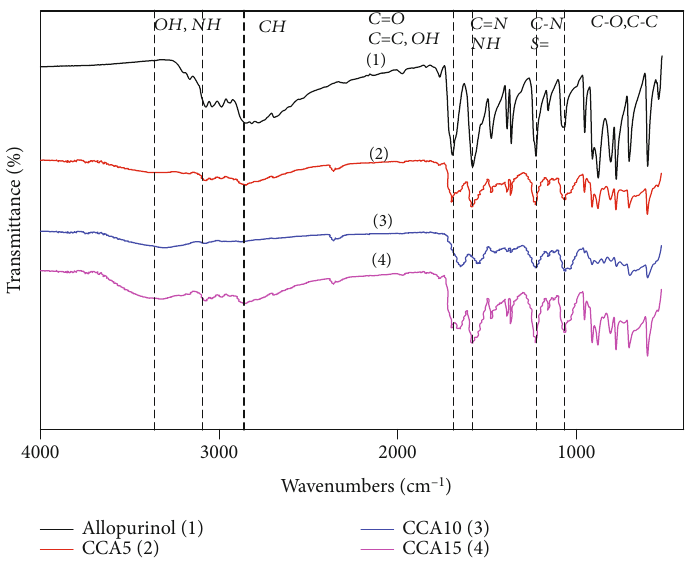
Figure 2: IR spectra of allopurinol and CCA biocomposite fi lms. Table 1: Vibrations of some functional groups of allopurinol, collagen, carrageenan, and CCA biocomposite fi lms.